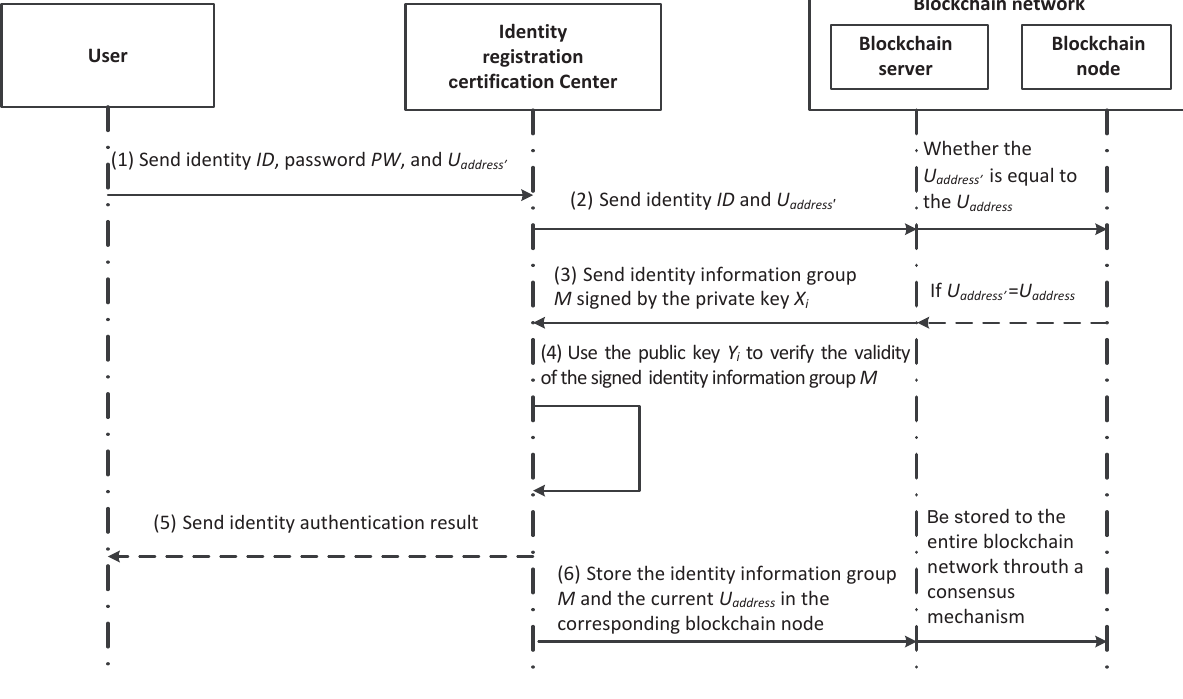
Fig. 4 Workflow of the identity authentication